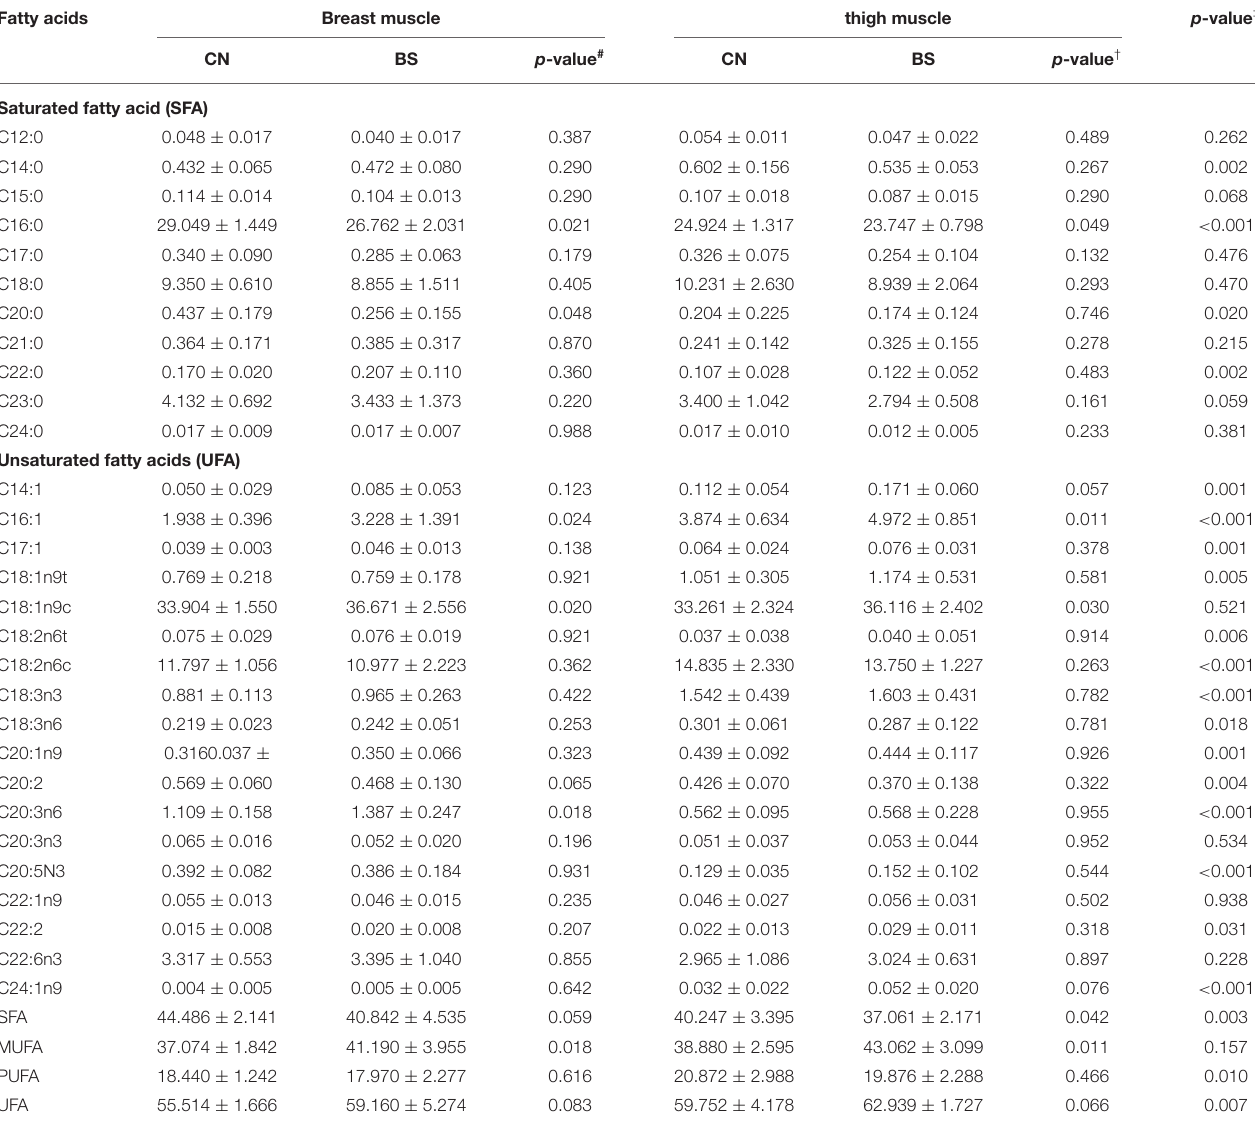
TABLE 6 | Effects of Bacillus subtilis supplementation on fatty acids content in breast muscle and thigh muscle of broiler chickens (%). Fatty acids Breast muscle thigh